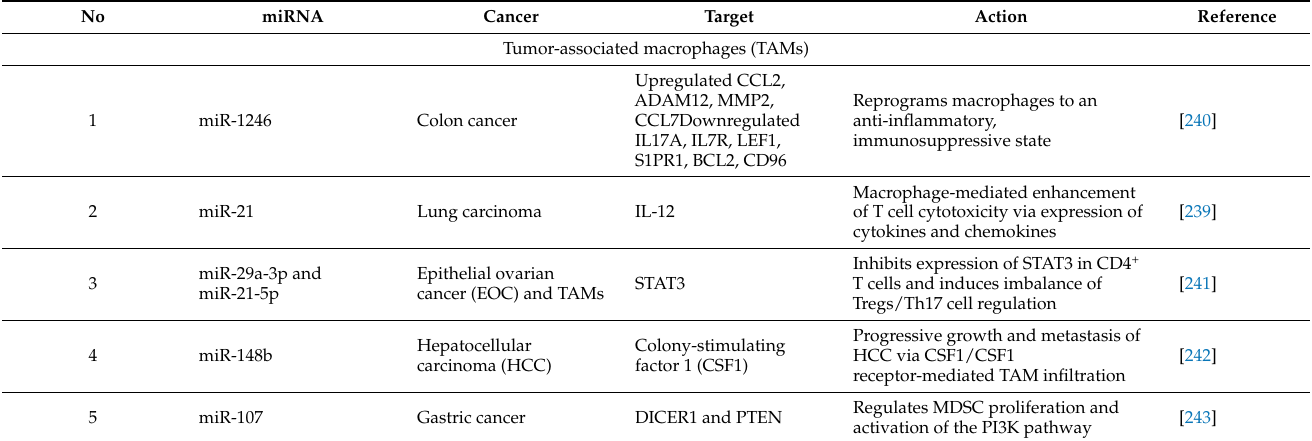
Table 11. The miRNAs implicated in immune